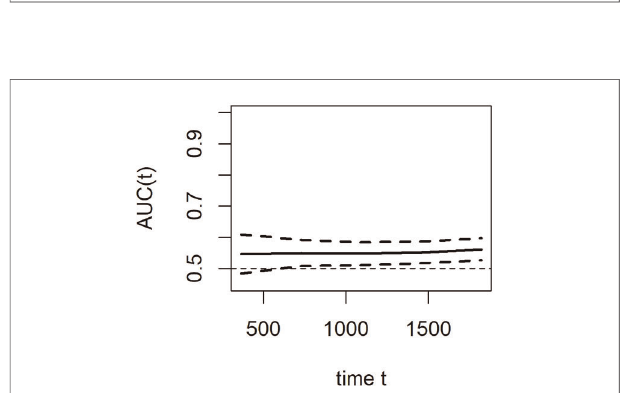
FIGURE 4 | Time-dependent ROC curves indicated the prognostic value of PNI for OS in HCC patients within Milan criteria after